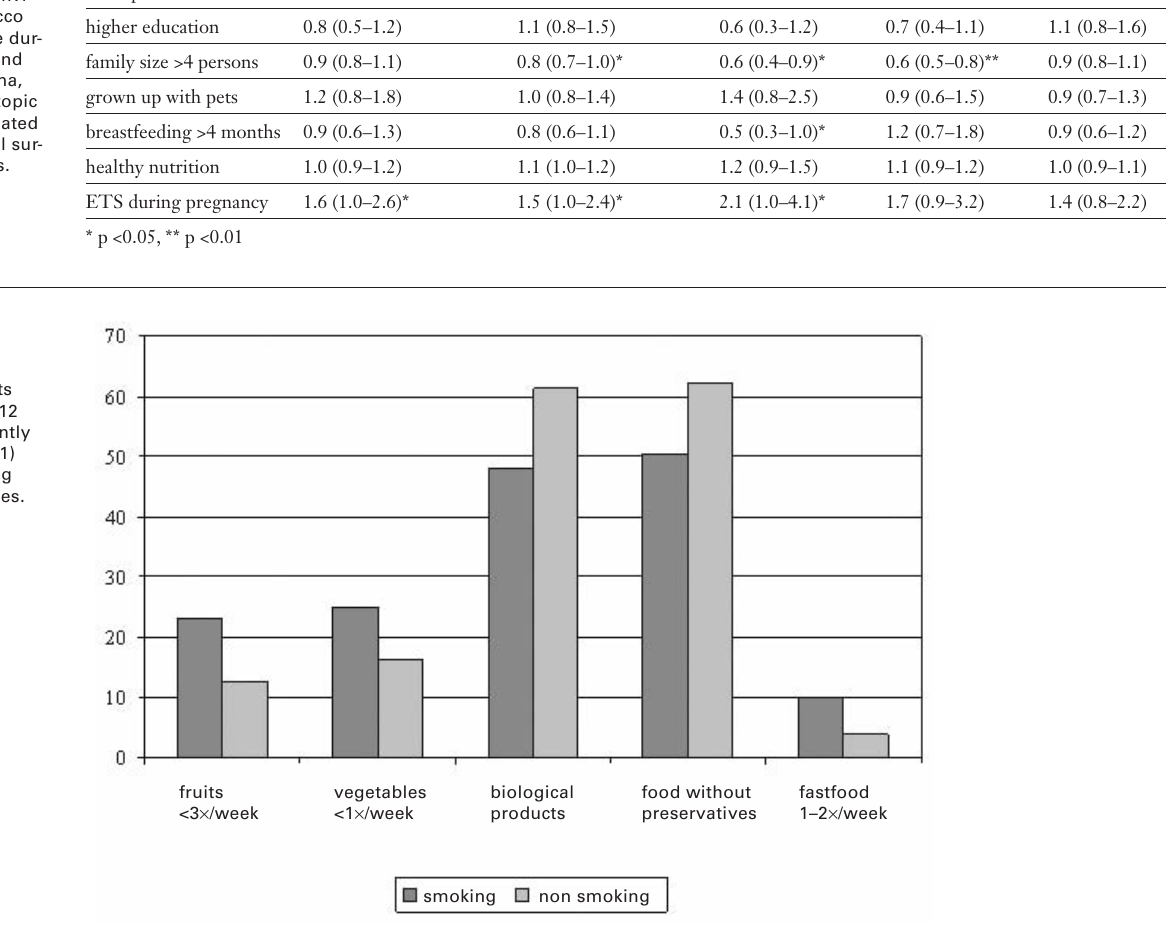
Associations (odds ratios (OR) and 95% confidence interval (95%CI) between sex, age, family history, education, family size, pets, breastfeeding, envi- ronmental tobacco smoke exposure dur- ing pregnancy and wheezing, asthma, hay fever and atopic dermatitis evaluated through the final sur- vey logit models.